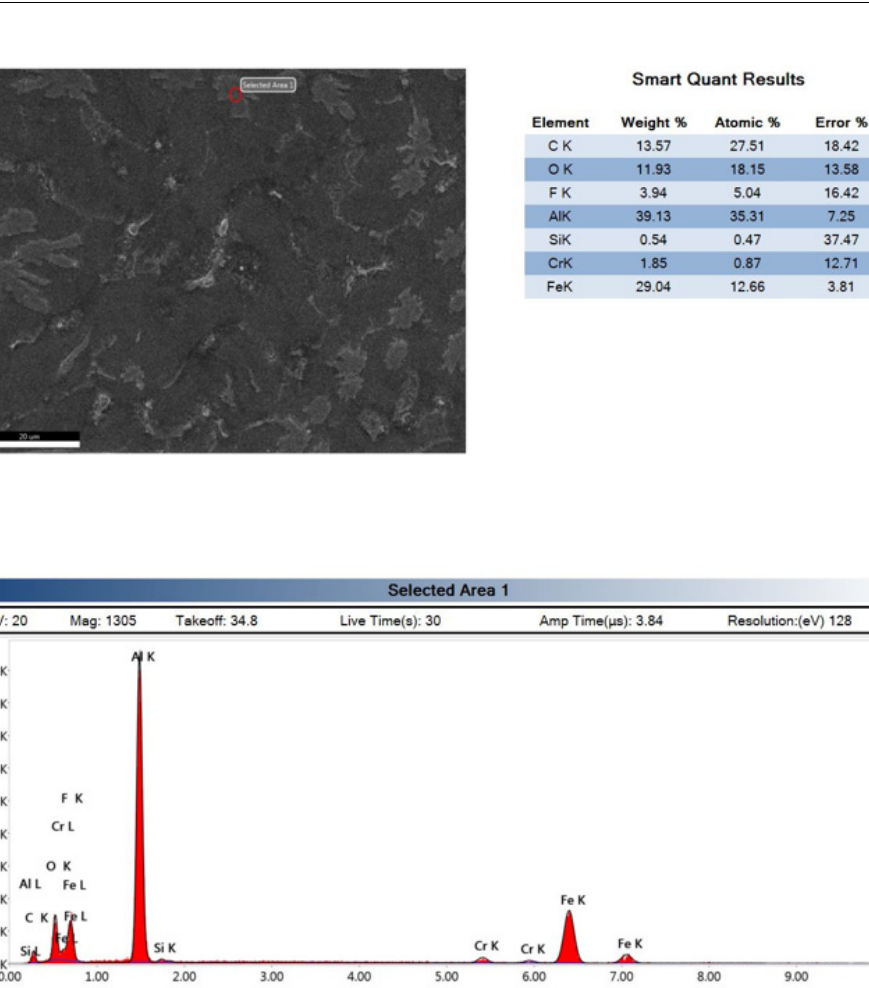
Figure 10. EDX of the Al6061 after 20 min of stirring. The microstructural of Al6061/TiO 2 composite samples with different loading frac- tions fabricated using the selected stir casting parameter, stirring at 1000 rpm for 10 min, is illustrated in Figure 11A–F .